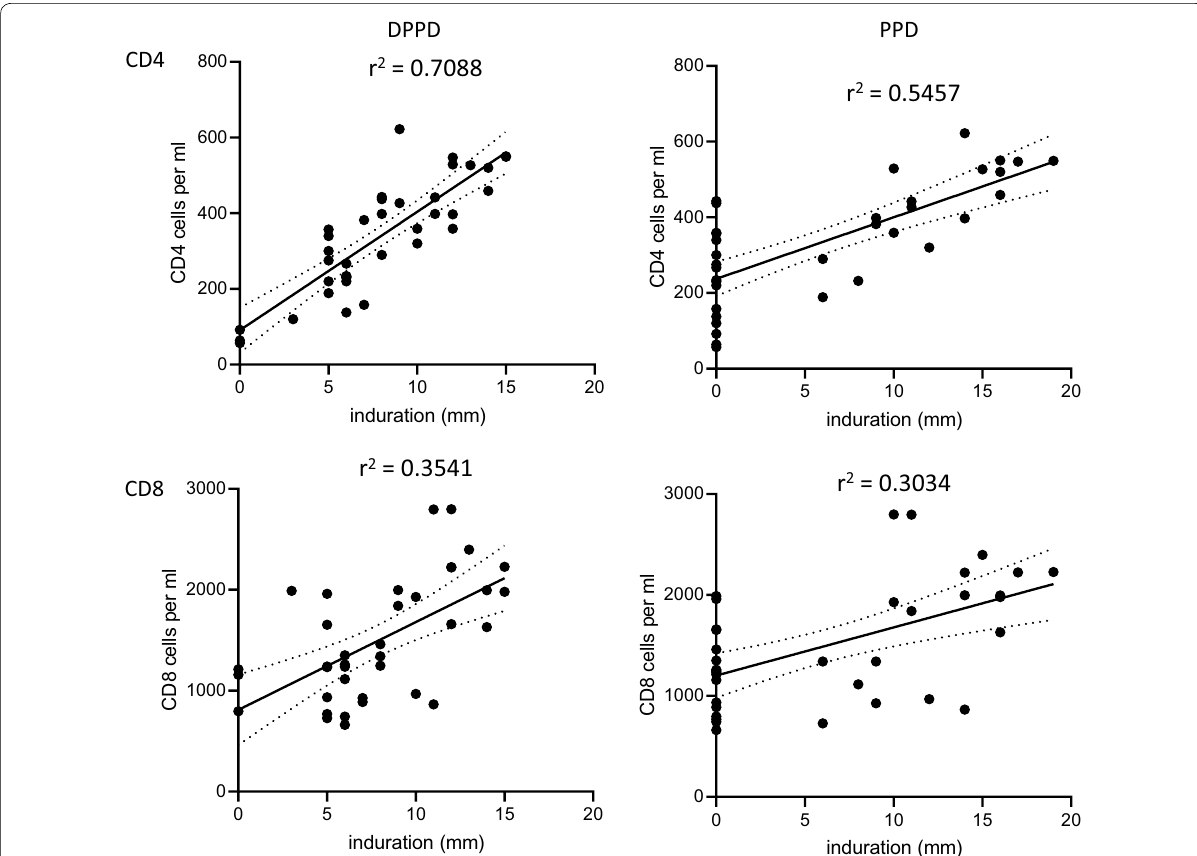
Fig. 2 Correlation of T cell numbers with antigen‑induced induration. CD4 and CD8 T cell counts were measured for TB patients that were HIV positive (n 38) and are plotted against the skin induration measured 24 h after they were intradermally inoculated with either 5 TU of Tubersol = PPD Tuberculin or the bioequivalent 1 µg of DPPD. Each dot represents an individual data point, while the solid line represents the correlation of results and the black dotted lines represent the 95% confidence intervals. The r 2 value is indicated in the text insert. In B, per cent of each group falling within the indicated induration range is